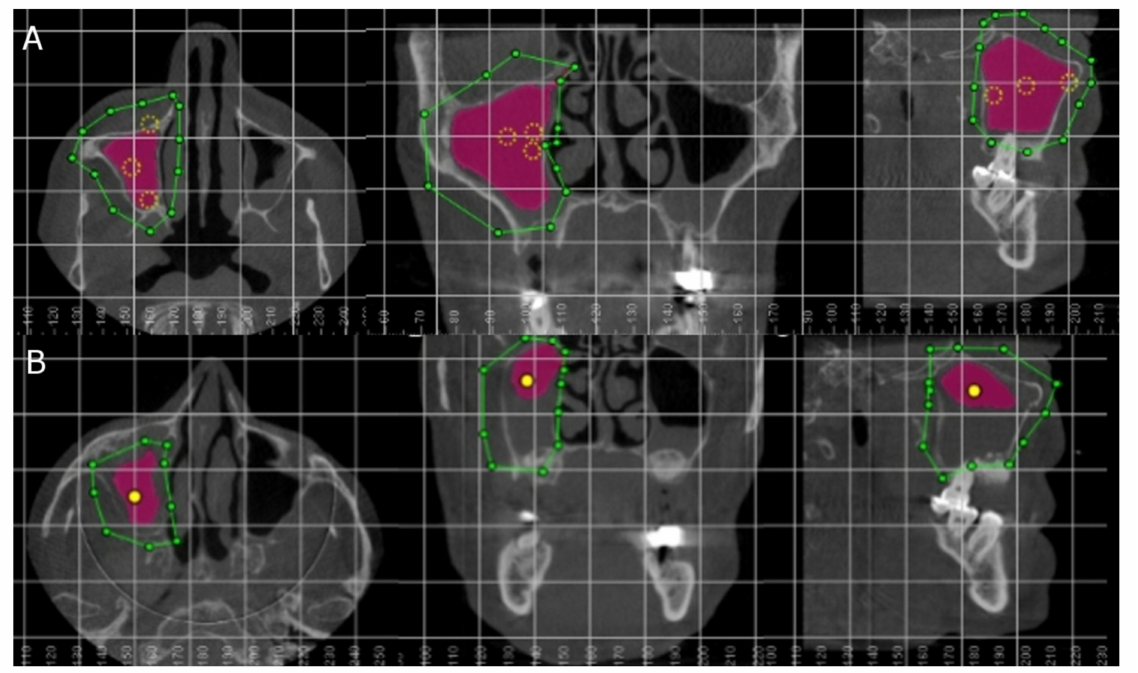
Figure 2. ( A ) Axial, coronal, and sagittal plane of the preoperative and ( B ) postoperative CBCT scans. Green line describes the selected area, yellow points define the air density, and purple area indicate the volume airway of the right maxillary